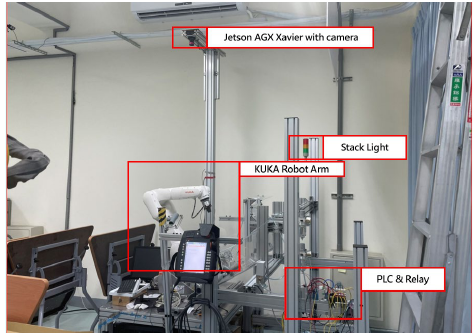
Figure 8. Install the AI module on the workstation.